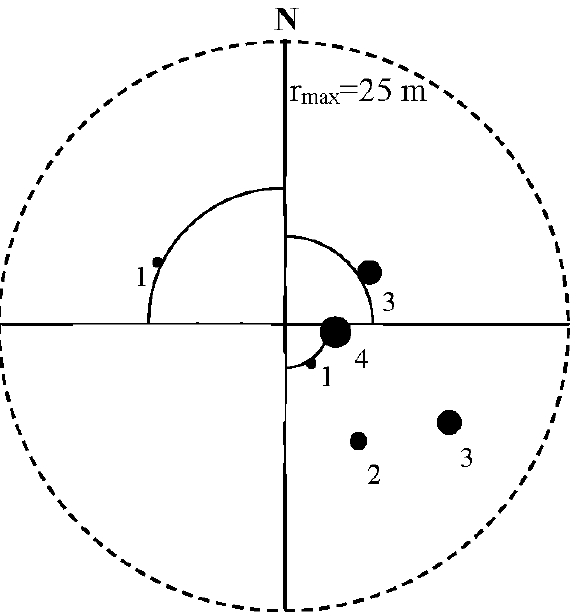
Figure 5. An example from one of the 40 point-centered quarter sampling plots. The figure illustrates a case with trees (black dots) present in three of the four quadrants. The numbers represent the four height classes of the trees (1: <1 m. 2: 1–2 m. 3: 2–3 m. 4: >3 m). The closest tree to the center point in each of the four height classes were sampled in each quadrant. Maximum allowable search radius (plot size) was r max = 25 m. The inner quarter circles indicate the areas searched for non-tree echoes with h > 0 m in the analysis of individual echoes (see text for further details).